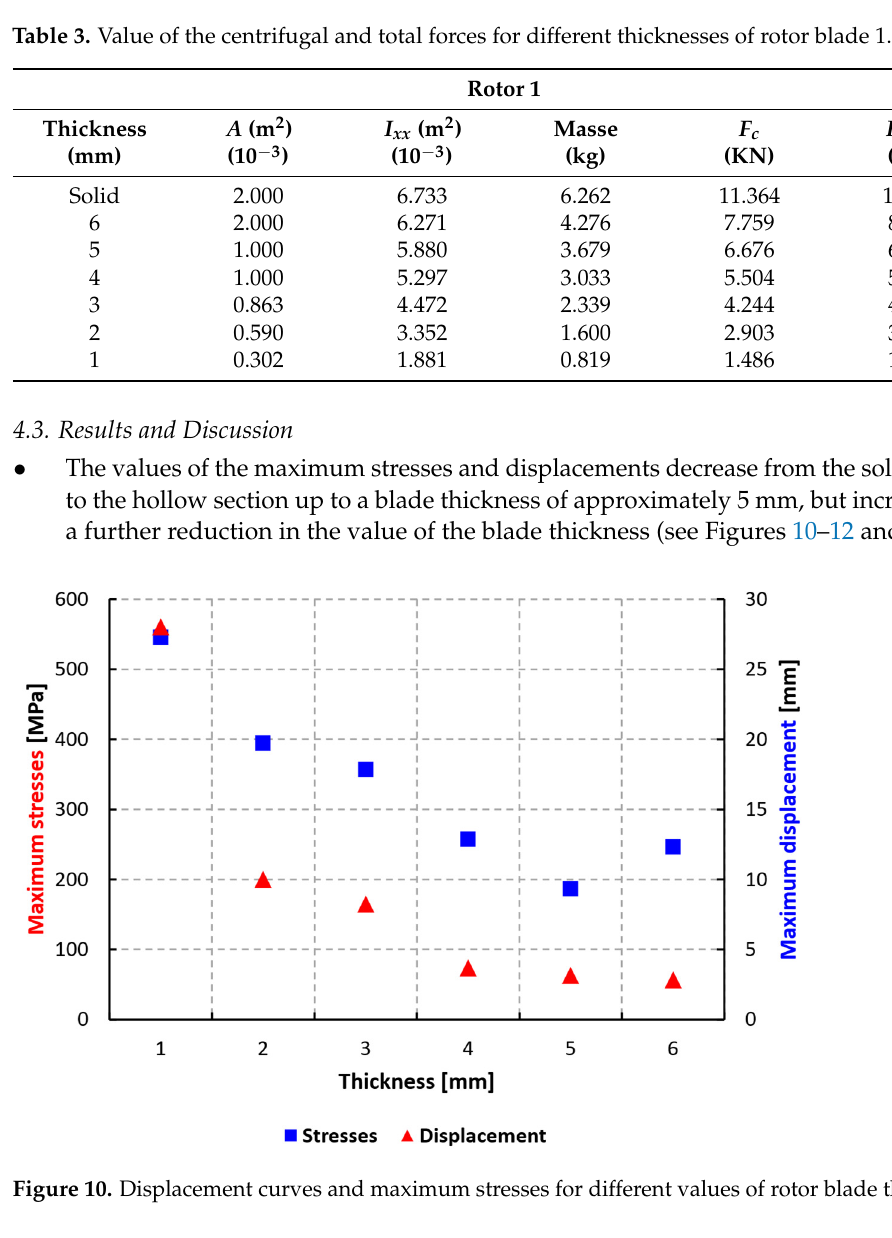
Table 3. Value of the centrifugal and total forces for different thicknesses of rotor blade 1.